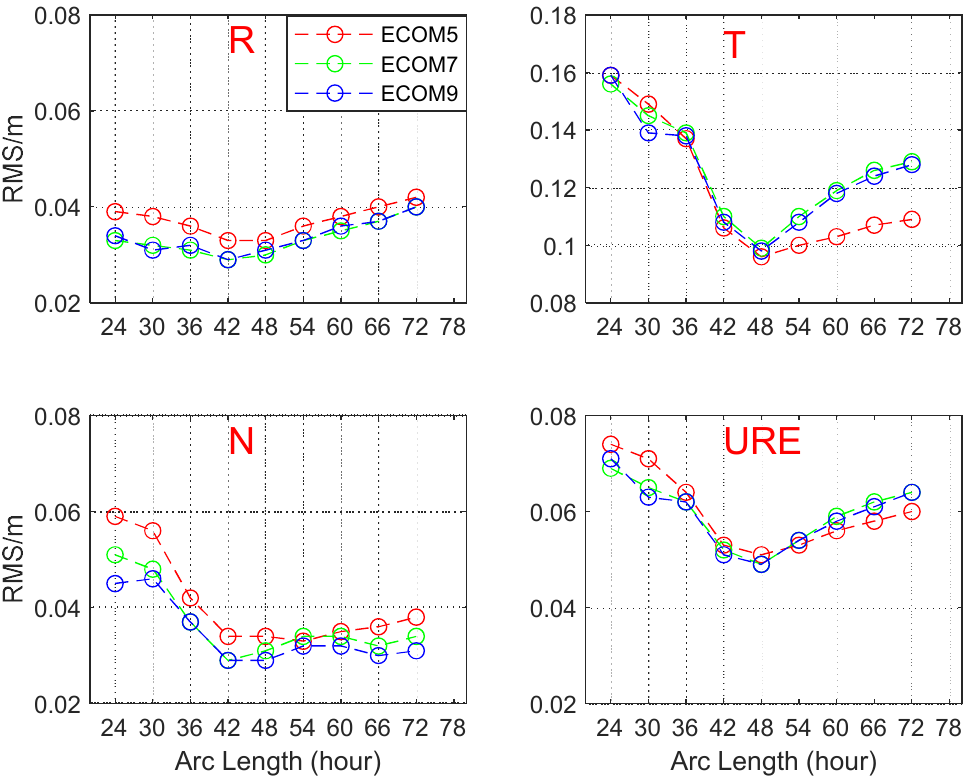
Figure 8. Average RMS and URE of BDS-3 predicted orbits with different ECOM SRP models out of eclipse seasons (24 h prediction interval).